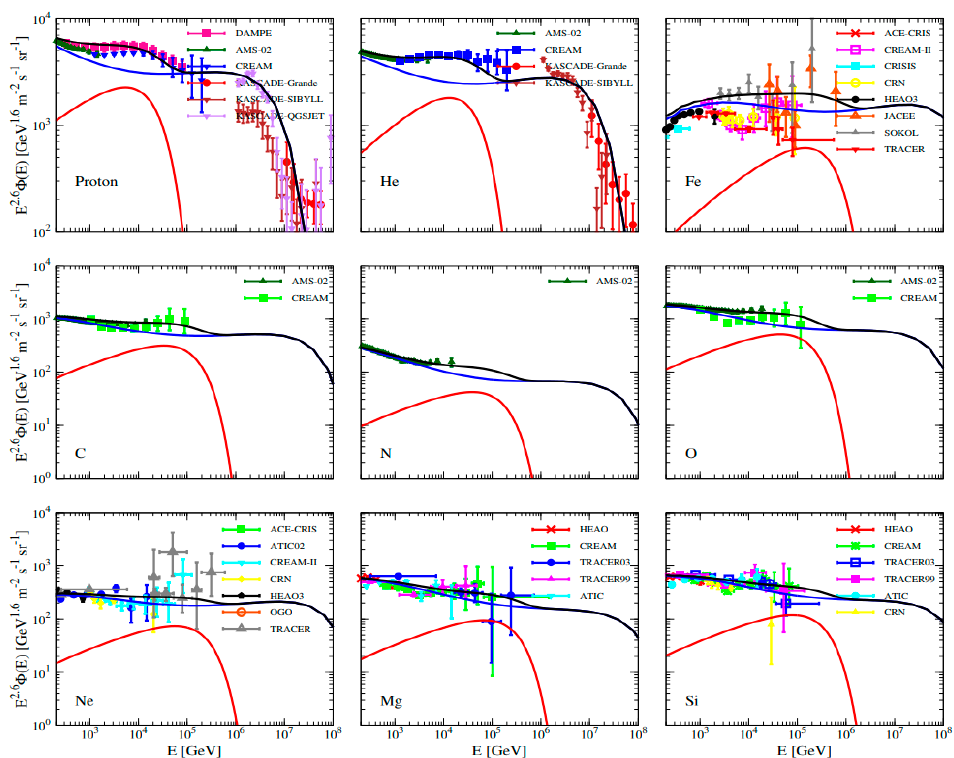
Figure 2. The calculated energy spectra of proton, He, C, N, O, Ne, Mg, Si and Fe nuclei. The red and blue lines are the fluxes from the nearby and background sources, and the black line is their sum. For protons, He, C, N and O, the data points are taken from AMS-02 [71–74], CREAM [14,75], and KASCADE [70,76], respectively. For Ne, Mg, Si, and Fe, the data points are from HEAO [77], TRACER [78–80], ATIC [81], JACEE [82,83], SOKOL [84], CRISIS [85], ACE-CRIS [86] and CRN [87]. We further calculate the all-particle spectra of GCRs, as shown in Figure 3, which are consistent with the observational data.